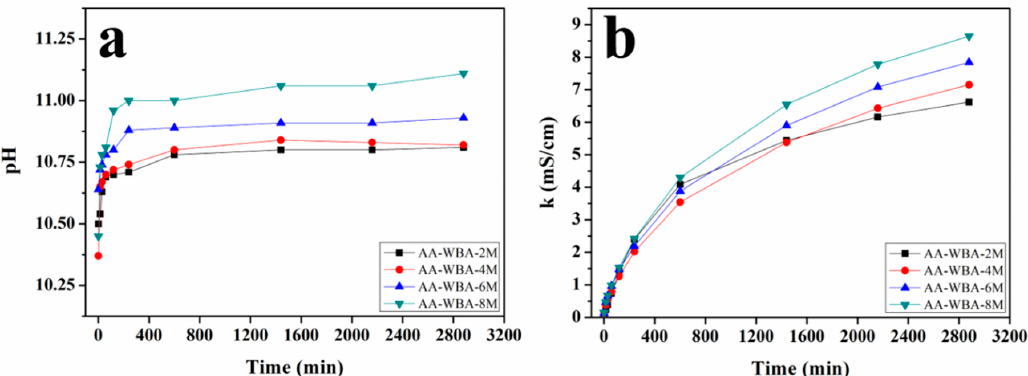
Figure 3. Alkali-activated weathered bottom ash binders’ (AA-WBAs) values of ( a ) pH ( b ) conductivity during the integrity test.